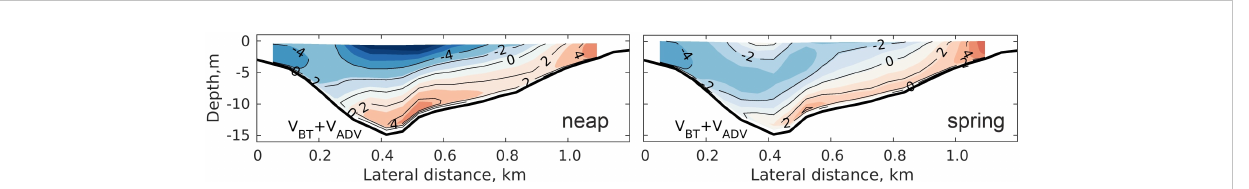
FIGURE 8 Transverse distributions of the across-channel residual fl ow due to advection (the sum of v Baro and v ADV ) during (left column) neap tide and (right column) spring tide. The unit in all contours is cm s − 1